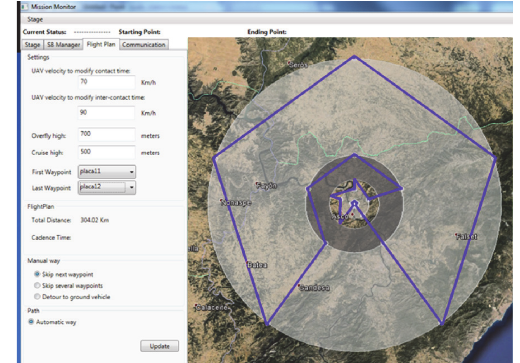
Figure 6: Flight plan 2. The RPAS does not visit all the waypoints.